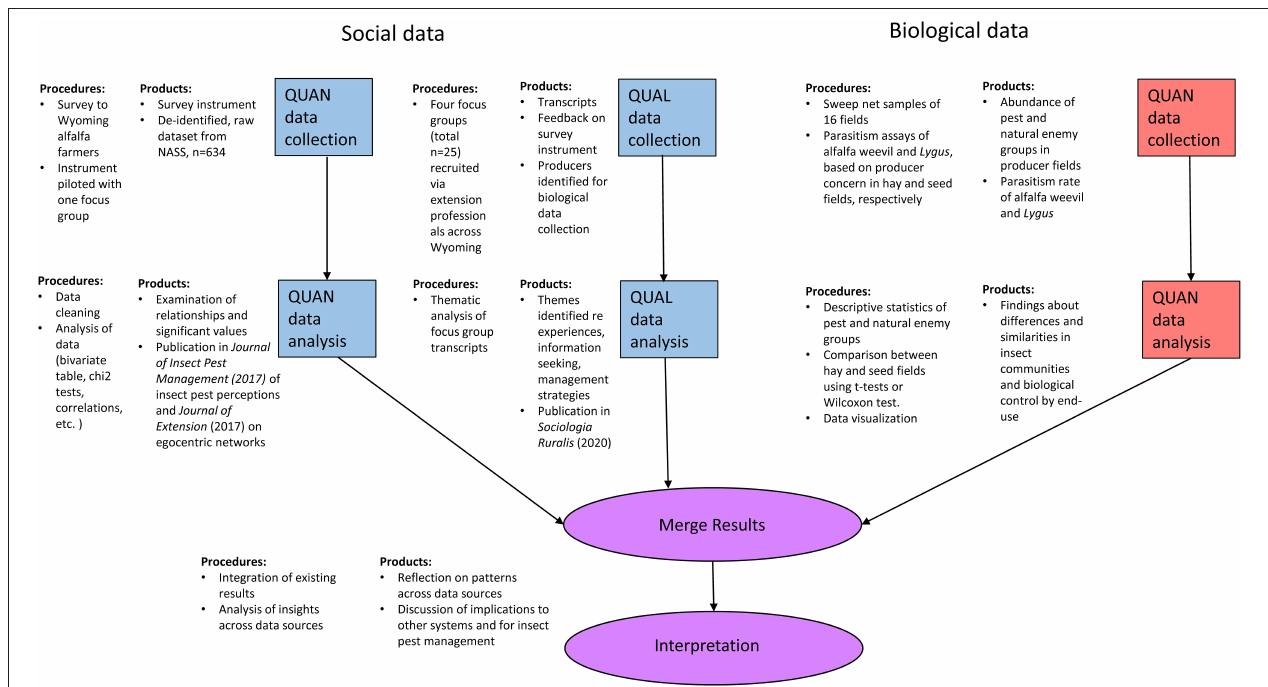
FIGURE 2 | Overview of mixed-methods research design and outcomes for overall project on alfalfa insect pest management in